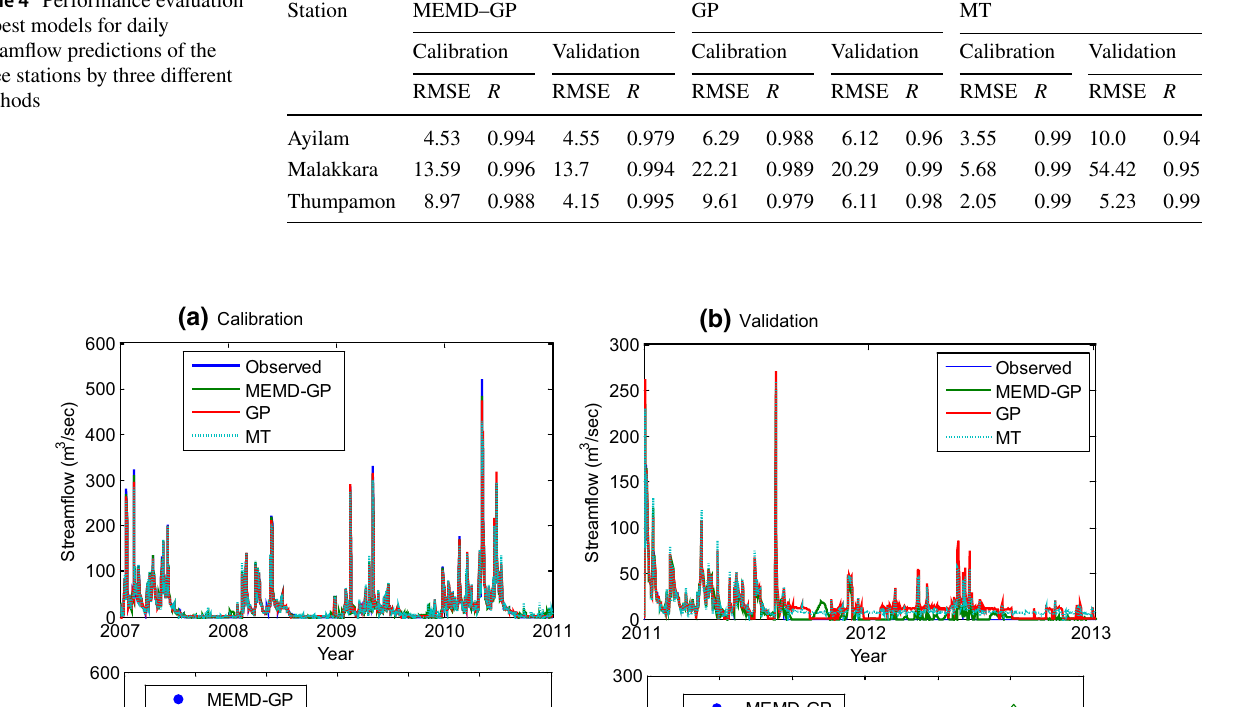
Table 4 Performance evaluation of best models for daily streamflow predictions of the three stations by three different methods